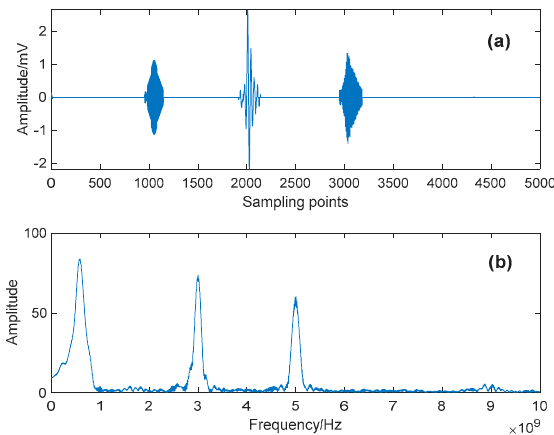
Figure 7. Denoising results by AVMDSSA: ( a ) Time-domain waveform; ( b ) Spectrum.